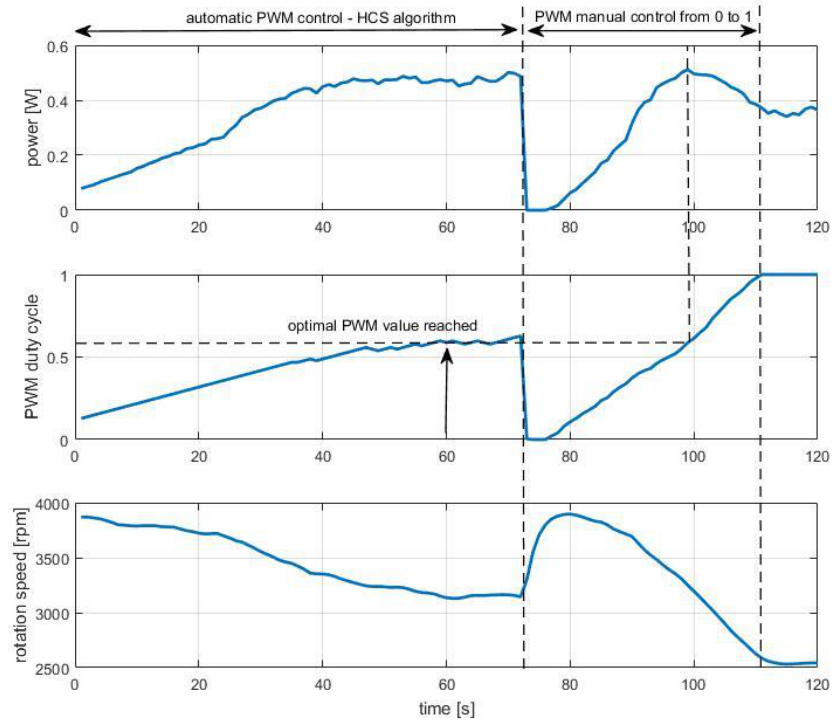
Figure 17. Graphs: microturbine power, duty factor PWM, and turbine rotation speed of a microturbine model controlled by HCS algorithm for adjustable pitch angle of the turbine blade.